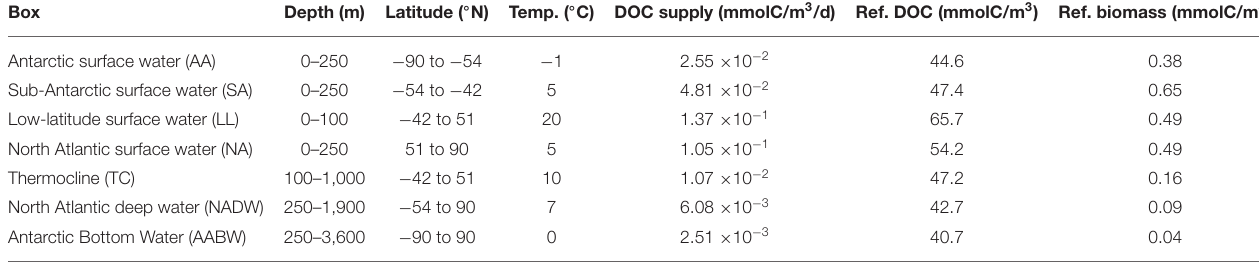
TABLE 1 | Properties of the seven boxes from the box model.